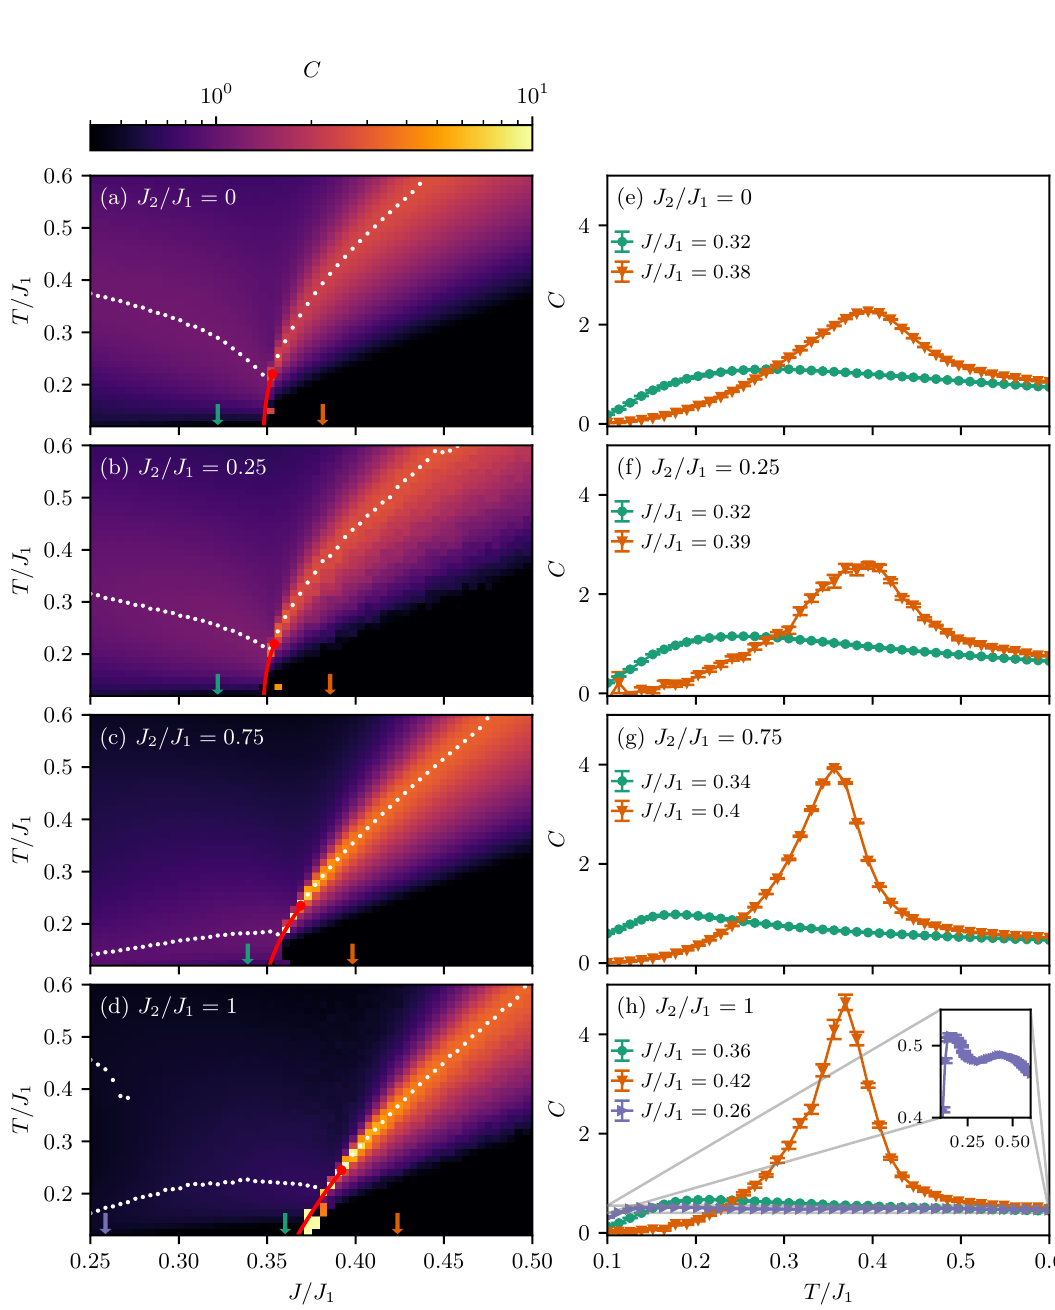
Figure 6: Specific heat, C ( J , T ) , of the L = 12 FFTL model for different values of / J J . (a)–(d) C as a function of J and T . For each fixed J , the temperatures, T max , 2 1 of the maxima in C ( T ) are shown as white dots. Red lines and points mark again the approximate first-order line and the numerically determined critical point. Arrows indicate the positions of the fixed- J cuts shown in panels (e)–(h). In panel (h), the inset shows a magnification of the cut at J / J